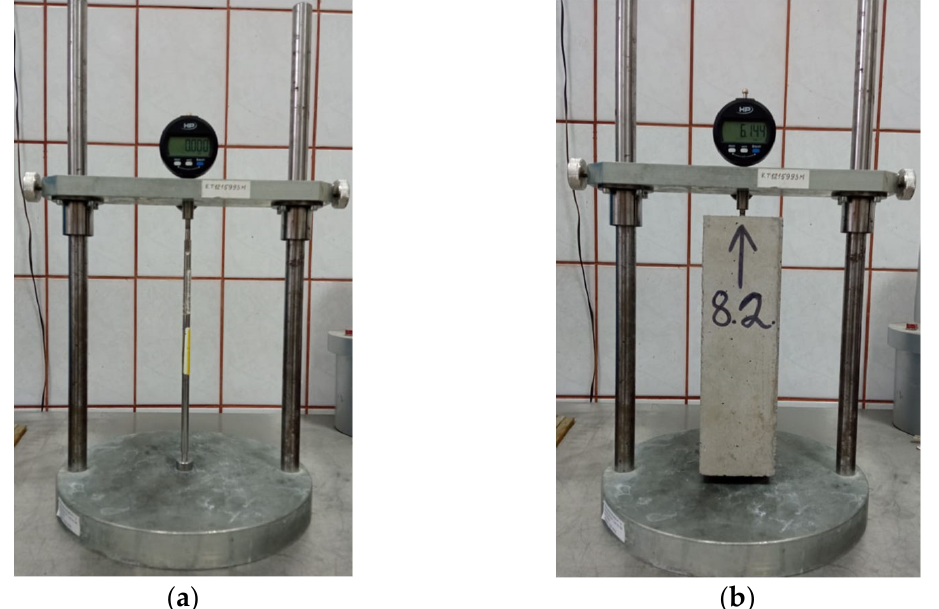
Figure 2. Images of prism length measurement after 90 days; ( a ) setting zero; ( b ) length measurement.